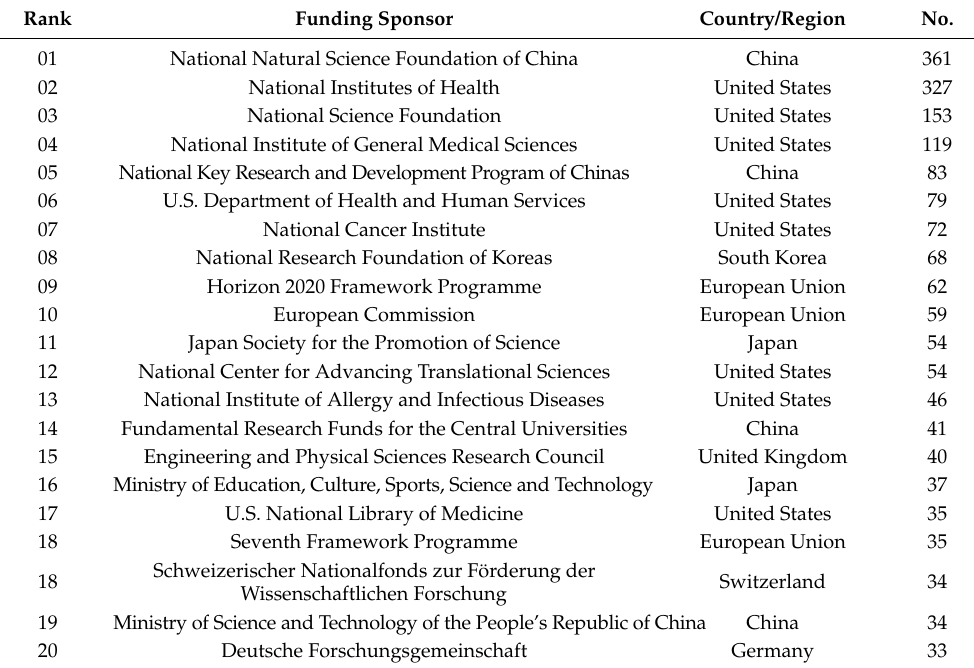
Table 5. Overview of the funding